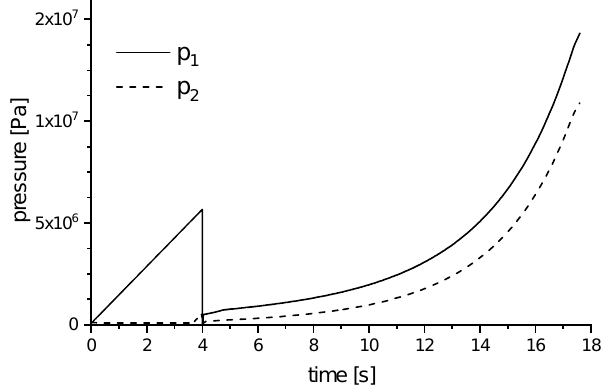
Figure 16. Cavity pressure development for sensors p 1 and p 2 of the sandwich